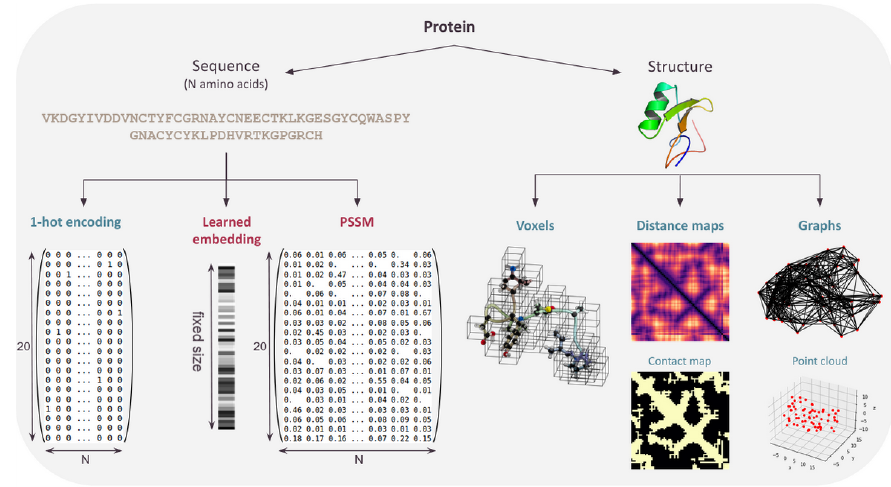
Figure 6. Various protein structure and sequence